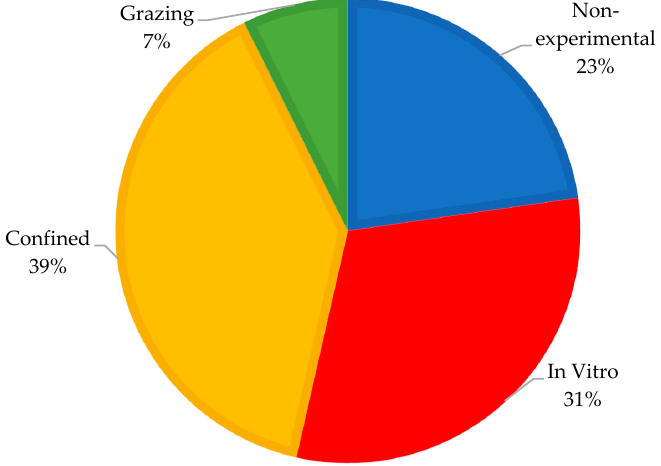
Figure 2. Distribution (%) of retrieved peer-review documents into Non-experimental, In vitro, Confined, and Grazing categories of methane emissions from ruminants.